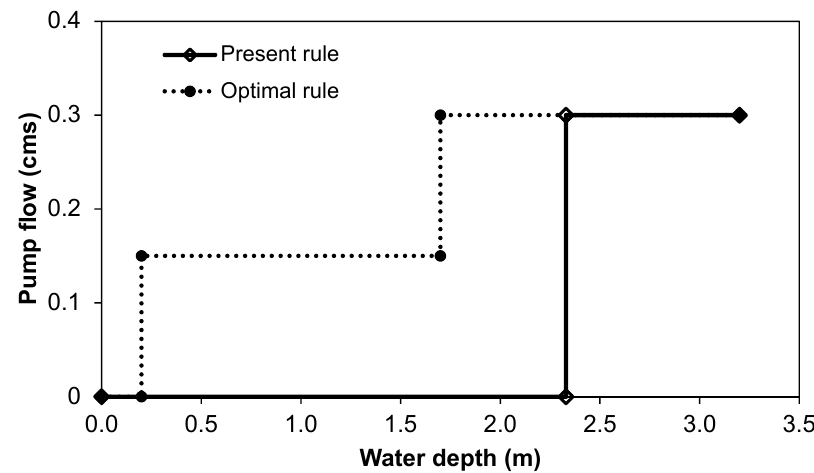
Figure 6. Present and optimal rule curves of pump station D in the detention basin. Water 2016 , 8 , x